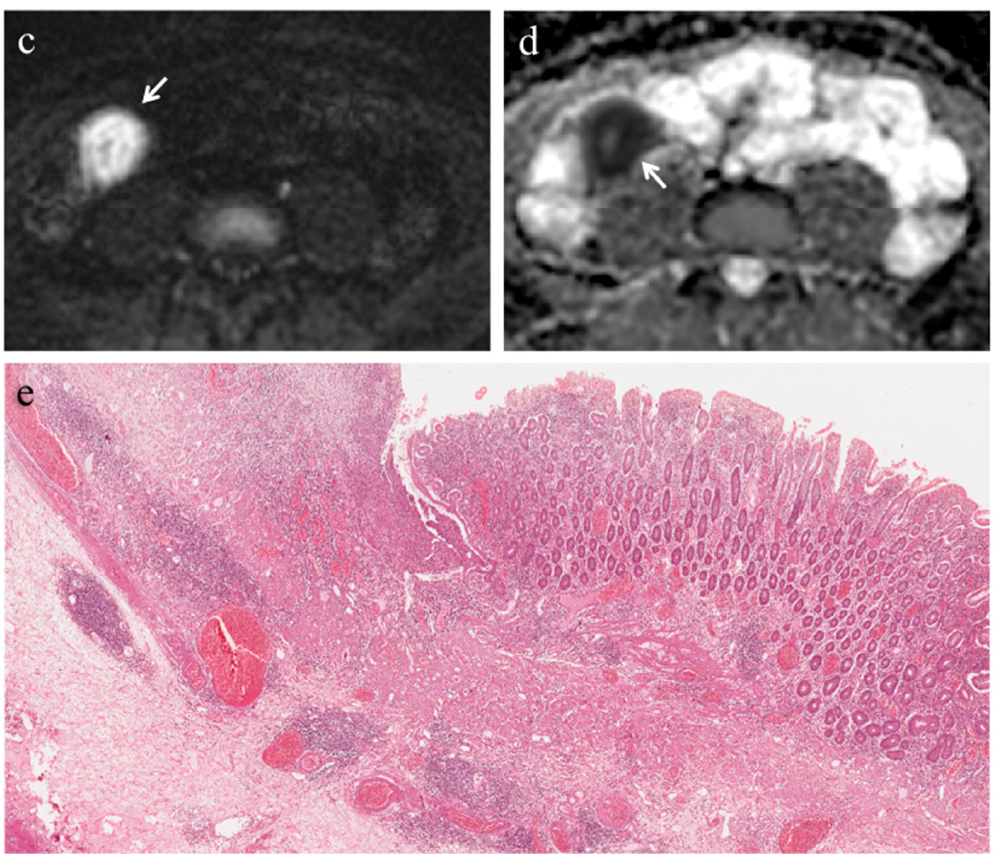
Figure 3. ( a – e ). MRE in a 22-year-old man with CD: predominantly inflammatory stricture of the terminal ileum. ( a ) Coronal FIESTA image shows mural thickening of terminal ileum with stenosis of the lumen (white arrow). ( b ) Coronal contrast-enhanced fat-suppressed T1-weighted image demonstrates the homogeneous wall enhancement of the affected ileal loop. The same intestinal segment demonstrates restricted diffusion in the form of high signal intensity on ( c ) the DW image (b = 800 s/mm 2 ) and low signal intensity on ( d ) the corresponding ADC map (white arrows) (mean ADC value 1.320 × 10 − 3 mm 2 /s). ( e ) Histopathological section from the ileal stricture: hematoxylin and eosin-stained sample (H&E 10 × ). CD exhibiting absent or minimal fibrosis (FS = 0) and severe inflammation (AIS = 9): mucosal ulceration and intense inflammatory infiltration on the top; edema and intense inflammatory infiltration in the submucosal layer.